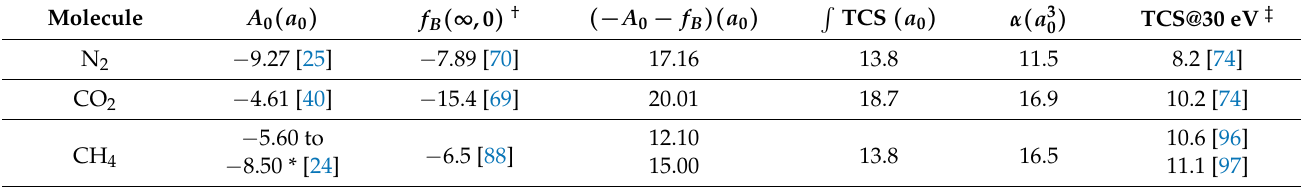
* depending on low-energy experimental data used for MERT fit. † The absolute values of the Born direct scattering amplitude f B ( E = ∞ , θ = 0 ) for positrons are taken as equal to those for electrons even if we do not have “exact” theoretical either experimental evidence; the optical model by Jochain and Potvliege [59] for Ar predicts at 100–300 eV and zero-angle the DCSs lower by a factor of two for positrons than for electrons; the sign of the Born amplitude is negative as the (static) interaction is repulsive. ‡ TCS in column 7 are in 10 − 16 cm 2